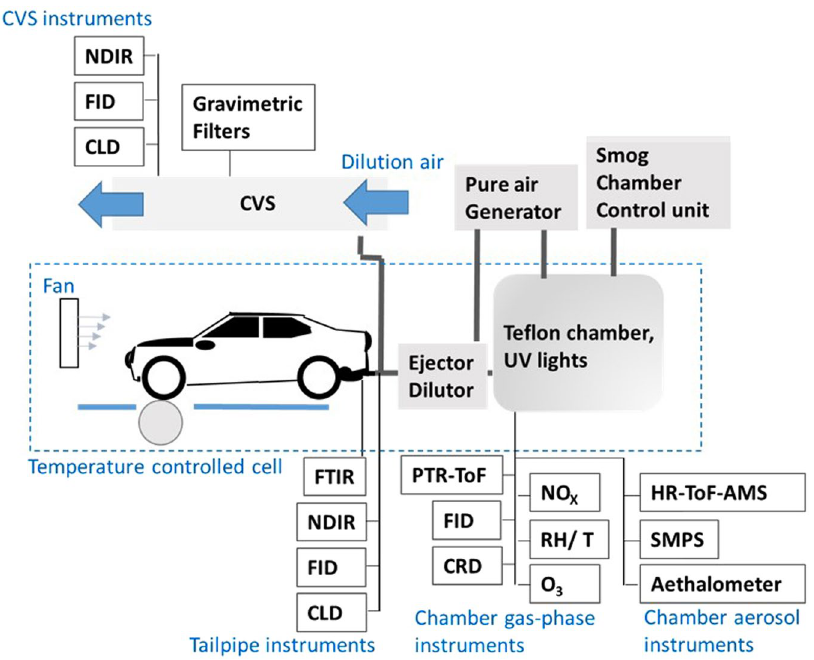
Figure 1. Schematic (not to scale) of the experimental set up. The test vehicle and smog chamber were operated inside the temperature controlled test cell with instrumentation outside. During testing, instruments were operated at the tailpipe and from a constant volume sampler (CVS), while a small fraction of emission were sampled into the smog chamber via a heated ejector dilutor (total dilution factor ~150). Tailpipe instrumentation included a Fourier-transformed infrared spectrometer (FTIR), non-dispersive infrared sensor (NDIR), flame ionisation detector (FID), and a chemiluminescence detector (CLD). At the CVS were NDIR, CLD, and FID instruments as well as a heated gravimetric filter sampler. After testing, primary emissions were investigated and then aged in the smog chamber under UV lights. Gas phase instruments were a proton transfer reaction time-of-flight mass spectrometer (PTR-ToF-MS), FID, cavity ring-down spectrometer, nitrogen oxide (NO X ) detectors, an ozone (O 3 ) monitor and relative humidity and temperature sensors (RH/T). Aerosol instrumentation was a high-resolution time-of-flight aerosol mass spectrometer (HR-ToF-AMS), a scanning mobility particle sizer (SMPS) and an aethalometer. Table S2 lists all chamber instruments in detail while Platt et al . 4 give a fuller description of this